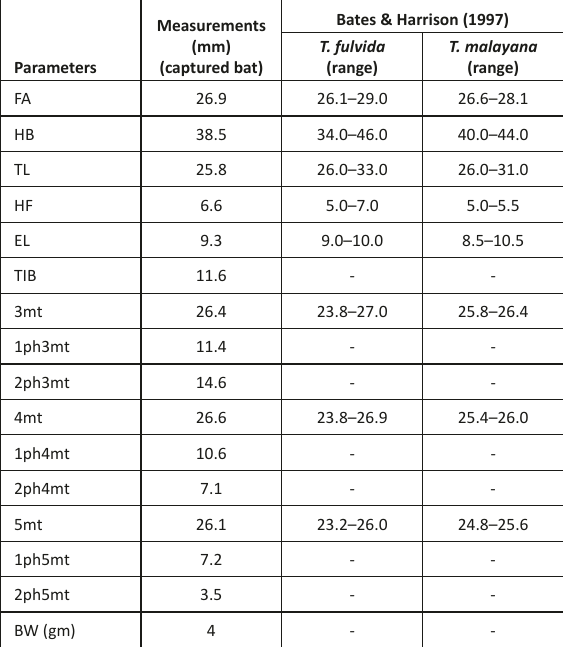
Table 1. Morphometric measurements of Tylonycteris sp. captured Gupteshore Cave at Kushma in Parbat, Nepal , compared with that